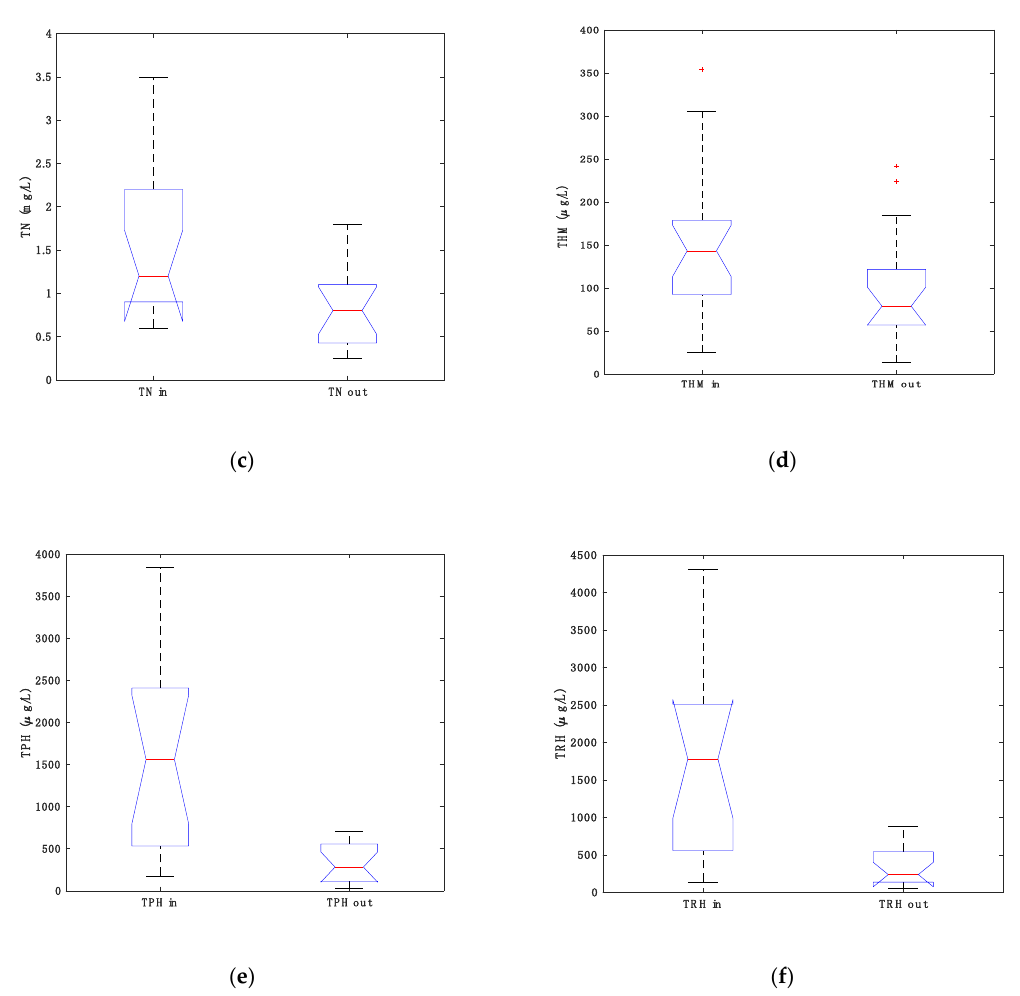
Figure 7. Box and Whisker plots for the pollutant: ( a ) TSS; ( b ) TP; ( c ) TN; ( d ) THM; ( e ) TPH; ( f ) TRH. Interleaved bar graphs of influent and effluent for all pollutants are also shown in Figure 8, which provide a direct comparison of the relative magnitude of the concentrations from the influent versus the effluent streams.